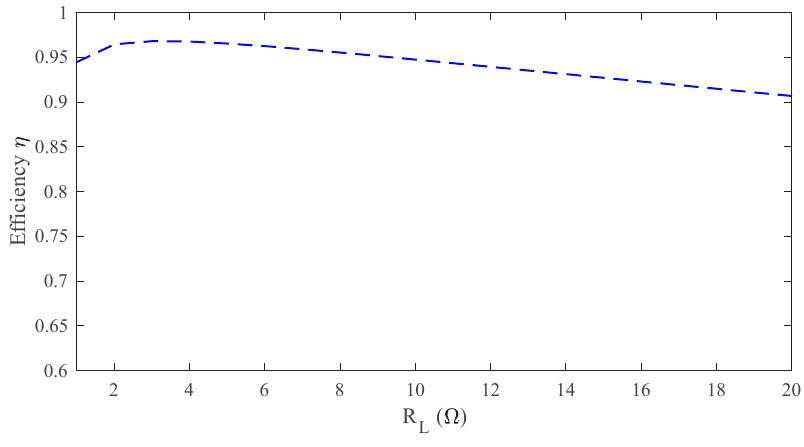
Figure 11. System efficiency versus load resistance R L . Figure 11. System e ffi ciency versus load resistance R L